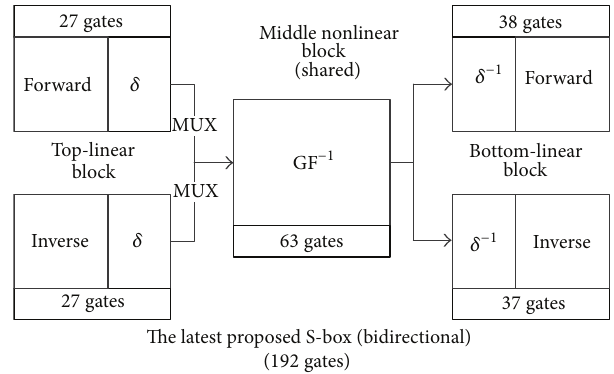
Figure 3: The illustration of Boyar’s updated minimized S-box (both forward and inverse S-boxes).